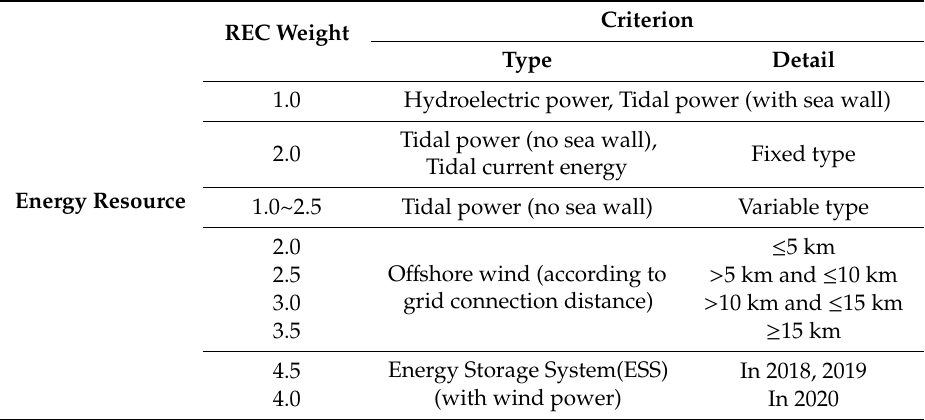
Table 1. REC certificate weights according to energy resources in Korea